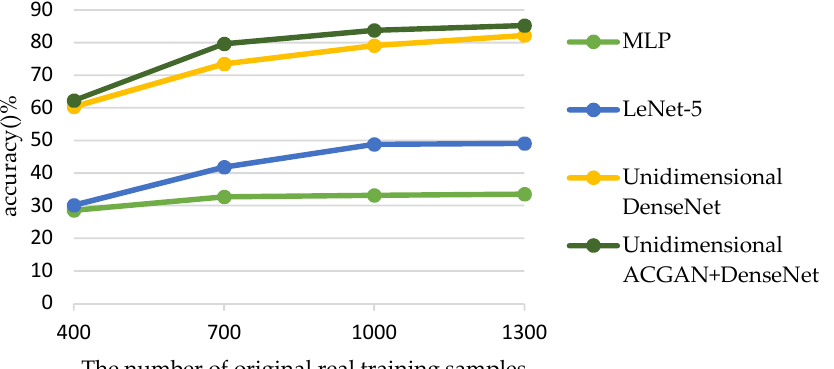
Figure 11. The number of original real training samples used to train unidimensional ACGAN changes and the recognition accuracy of the four algorithms.